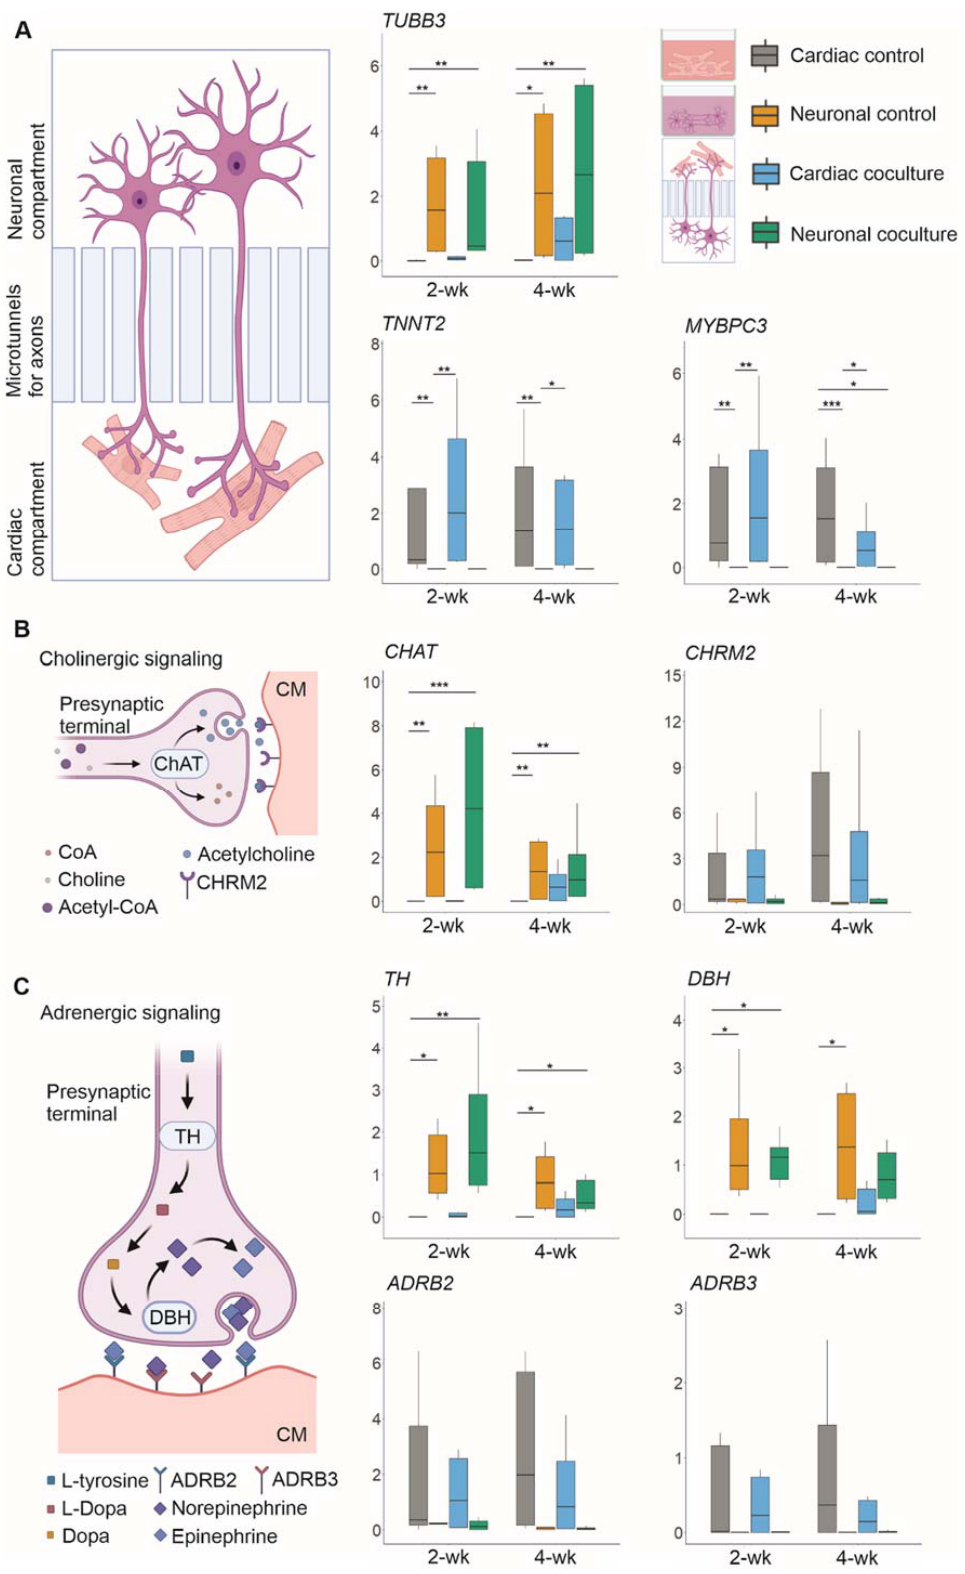
Figure 3. Relative expression of genes related to neuronal and cardiac identity, as well as cholinergic and adrenergic signaling. The data are presented as boxplots showing the median, upper, and